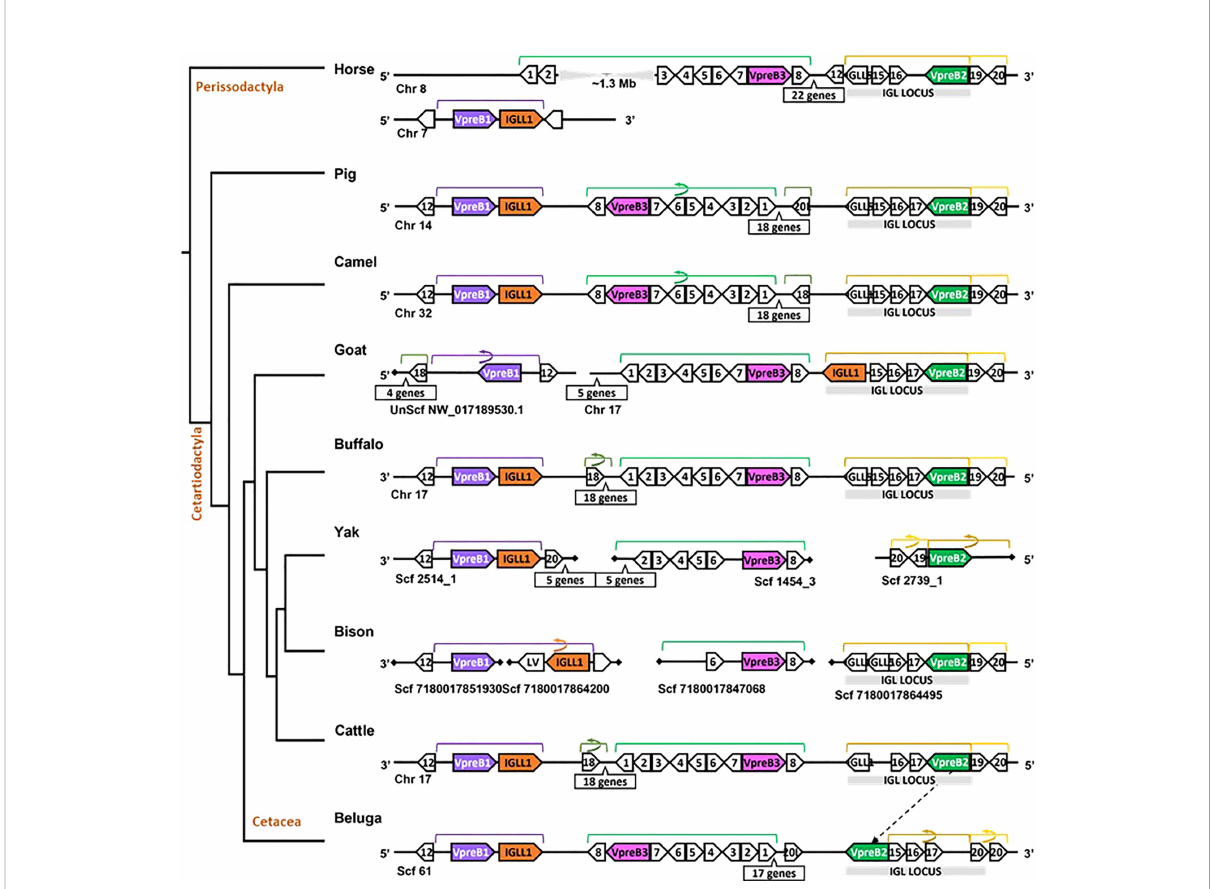
FIGURE 4 Locus synteny of VpreB3 and surrogate light chain (VpreB1, VpreB2, IGLL1) genes in cattle and their closest relatives. Genes are shown in pink (VpreB3), purple (VpreB1), green (VpreB2), and orange (IGLL1). Polygons containing syntenic genes found in two or more species contain a number corresponding to the gene name (see Figure 3 for genes represented by each numbered polygon). Polygons containing genes for uncharacterized proteins are empty. A solid line represents contiguous genomic sequence (chromosome or unplaced scaffold) and is denoted by the chromosome (Chr) or scaffold (Scf) to which it belongs. A line ending in a diamond shape indicates the end of a chromosome or scaffold and no further genes occur in that direction. Blocks of syntenic genes are indicated with the number of genes in a box below the line and long, unaligned regions with the genomic distance between syntenic genes. Blocks of syntenic genes are indicated with the number of genes in a box below the line. Orientation of chromosomes or scaffolds is indicated by the 5 ’ or 3 ’ labels at the ends of the solid lines, and gene polygons point in their transcriptional direction. Colored lines above the polygons denote syntenic gene blocks, and lines containing an arrow indicate the syntenic block is inverted compared to horse. The location of the lambda light chain locus (IGL, if present) is indicated by a gray rectangle. An arrow between genomes of two species indicates a gene that is translocated in one species. Orthologs between species are aligned vertically, but distances are not to scale. See Figure 1 and Supplementary Table 3B for a list gene names. A model cladogram is provided for reference. Tree topology is informed by published phylogenies (38). Created with